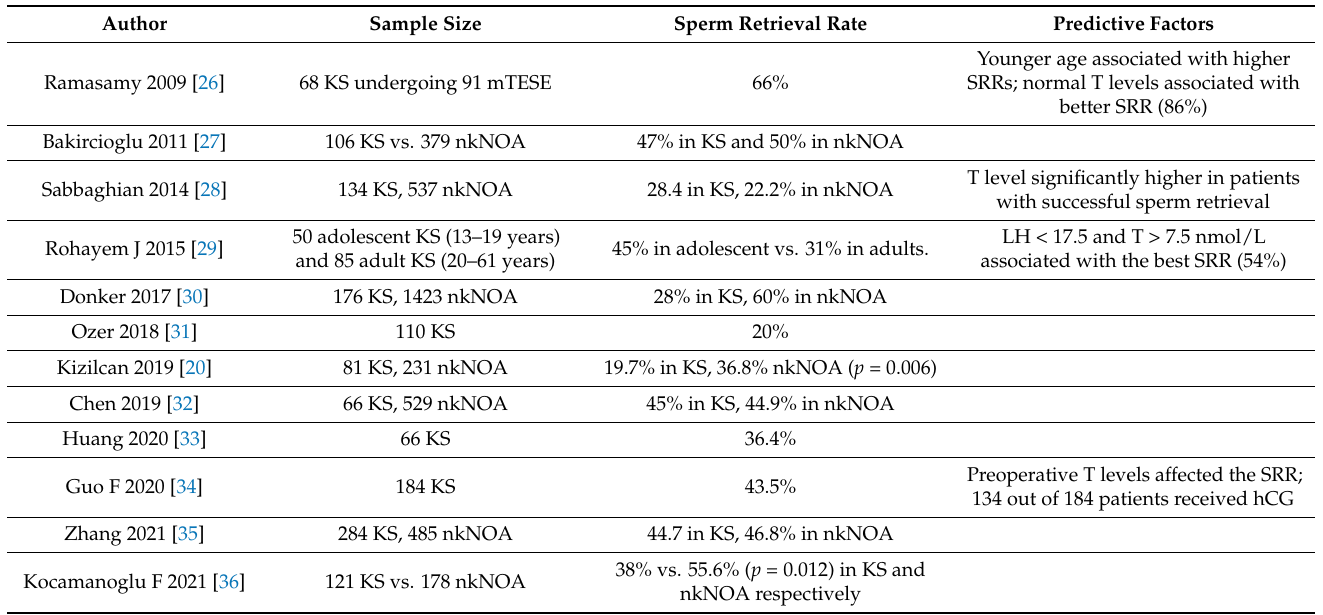
Table 1. Comparison of sperm retrieval rates in patients with NOA with normal karyotype or Klinefelter syndrome.